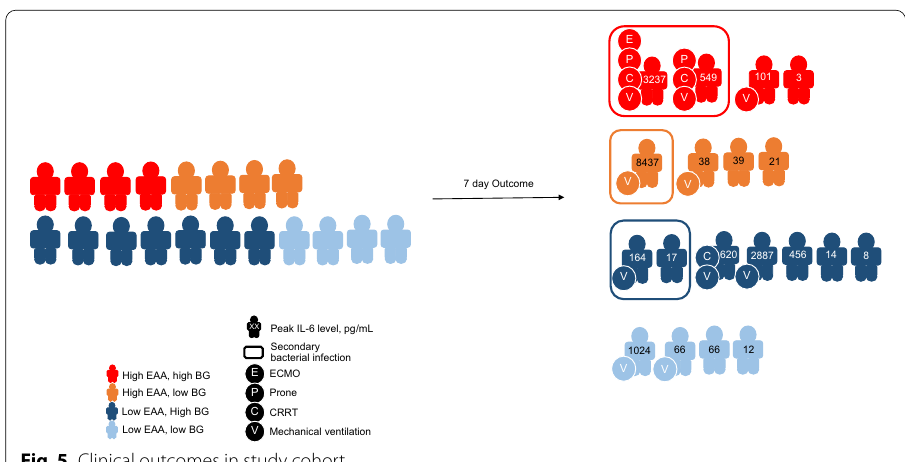
Fig. 5 Clinical outcomes in study